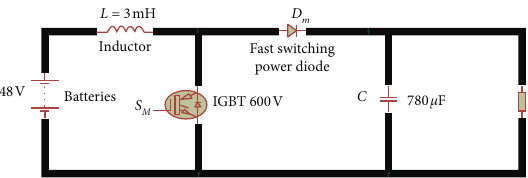
Figure 2: Proteus Circuit of DC-DC boost converter